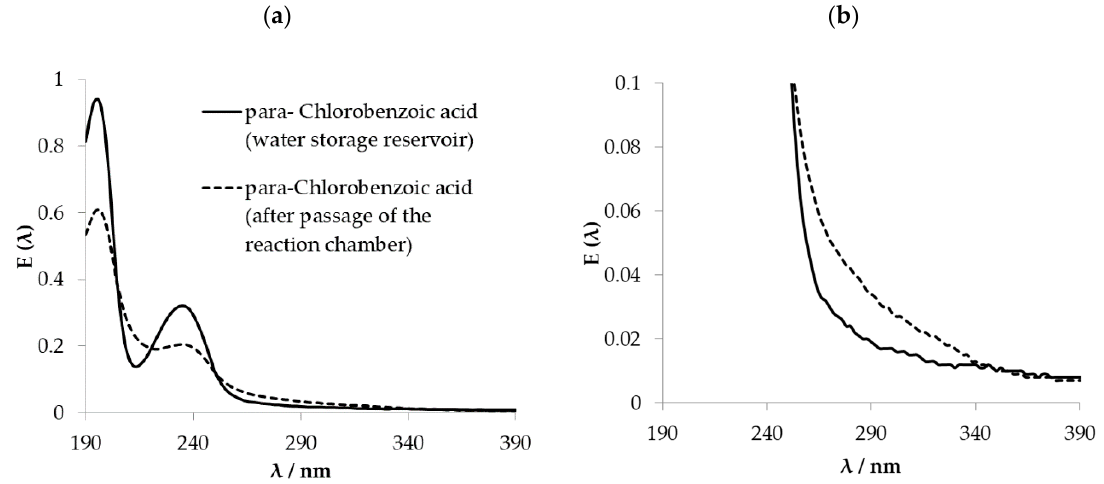
Figure 4. ( a ) Ultraviolet (UV)/visible range (VIS) spectrum of para-Chlorobenzoic acid in a sample from the water storage reservoir and in a sample after the treatment in the reaction chamber, ( b ) is the enlarged section of ( a